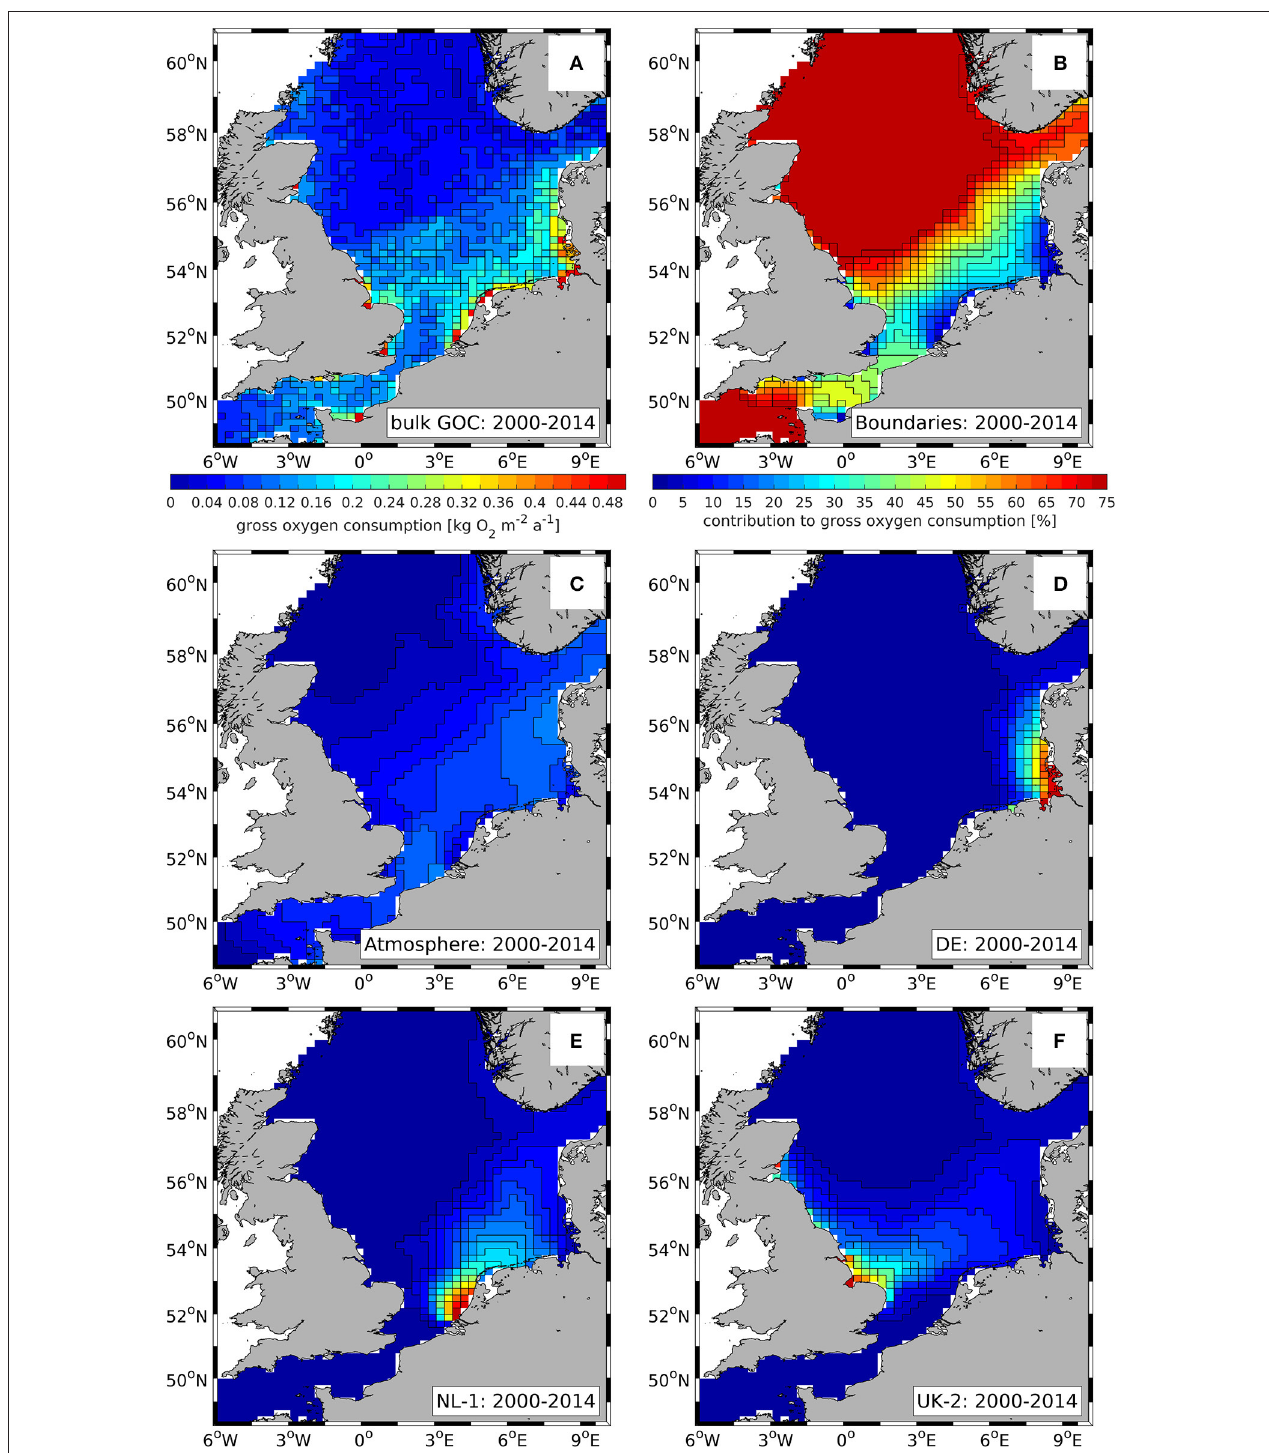
FIGURE 6 | Spatial distribution of (A) 15-year averaged, annual near-bottom gross O 2 consumption (GOC) and (B–F) average relative contributions due to N from different sources during 2000–2014: (B) boundaries (NA, EC, and BS), (C) atmosphere, (D) German rivers (DE), (E) 1st group of Dutch rivers (NL-1), (F) 2nd group of British rivers (UK-2). Both color scales cut at upper limits. Color scale of (B) also applies to (C–F) .